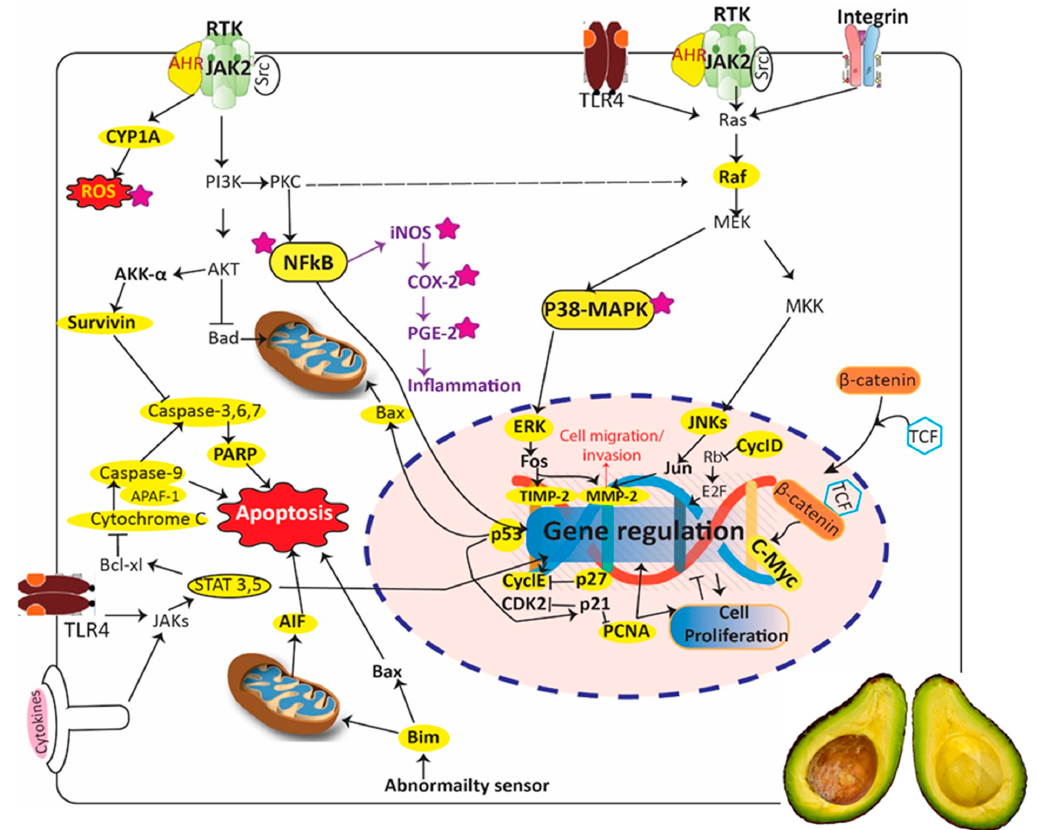
Figure 9. Effect of Persea americana (avocado) and its components on different cellular signal transduction pathways. The molecular targets highlighted in yellow play key roles in the proliferation, survival, migration/invasion, and apoptosis of cancer cells. Purple stars indicate the molecular targets involved in inflammatory response.